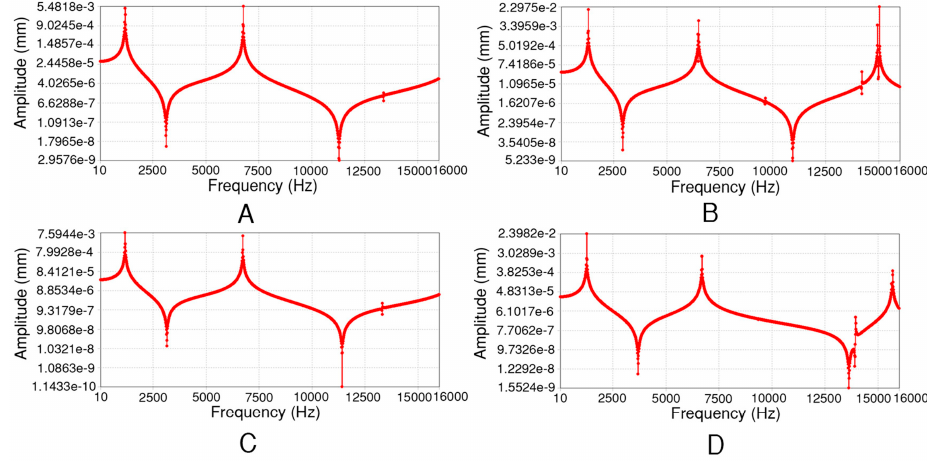
Figure 12. Amplitude response curve of ( A – D )-type end milling cutter in z direction.